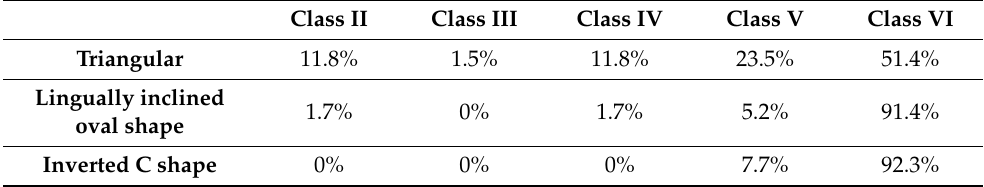
Figure 4. The distinctive shapes of the cross-sectional view of the anterior edentulous mandible; ( a ): triangular shape, ( b ): lingually inclined oval shape and ( c ): Inverted C shape. The shape of the mandibular ridge was also assessed within the Cawood and Howell classification subgroups (Table 5). Table 5. The percentages of each cross-sectional shape within Cawood and Howell classification.